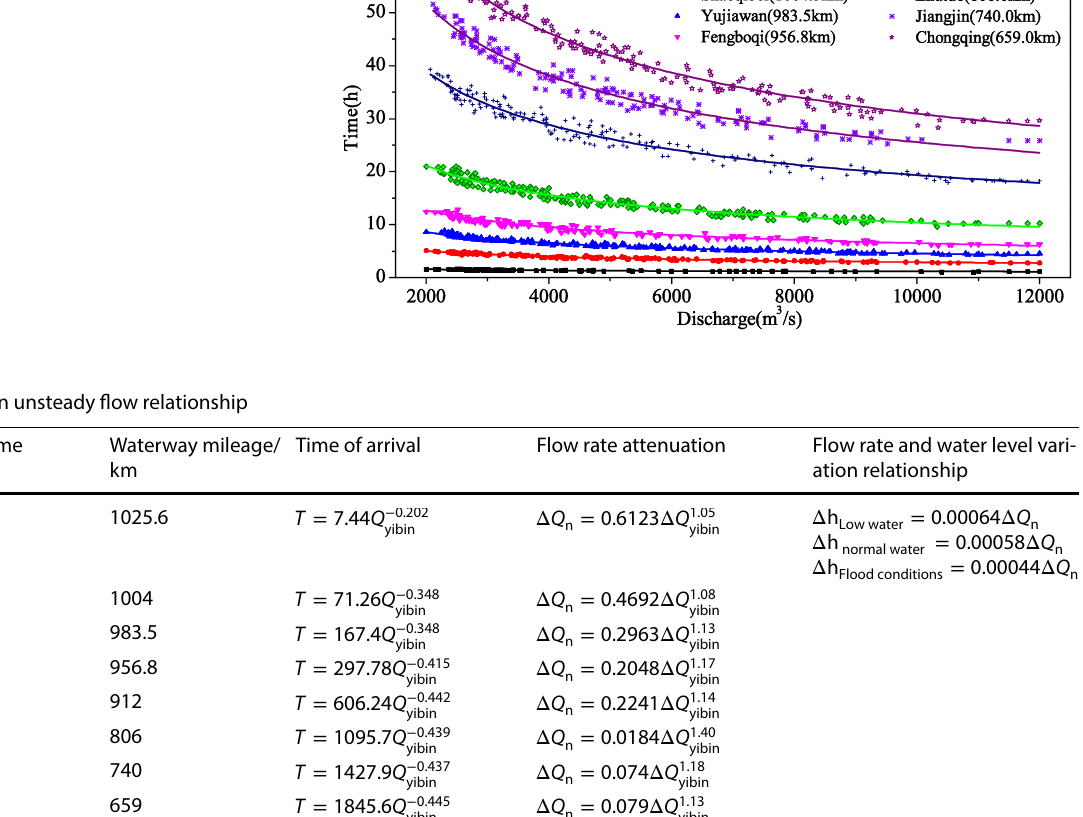
Fig. 17 Unsteady flow propa- gation